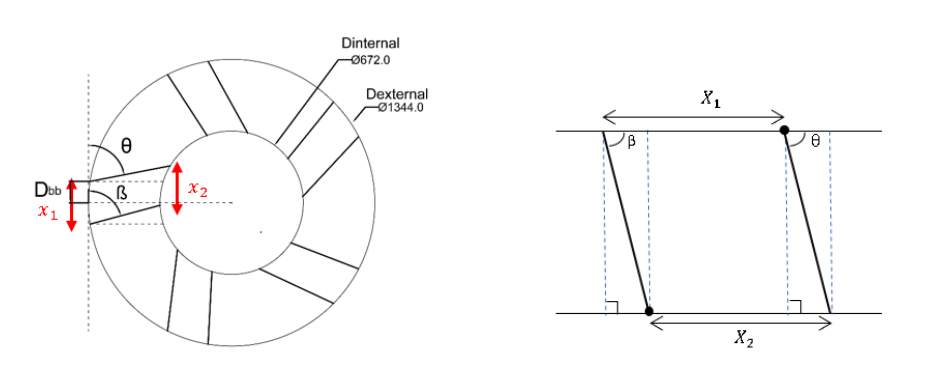
Figure 18. Parameter